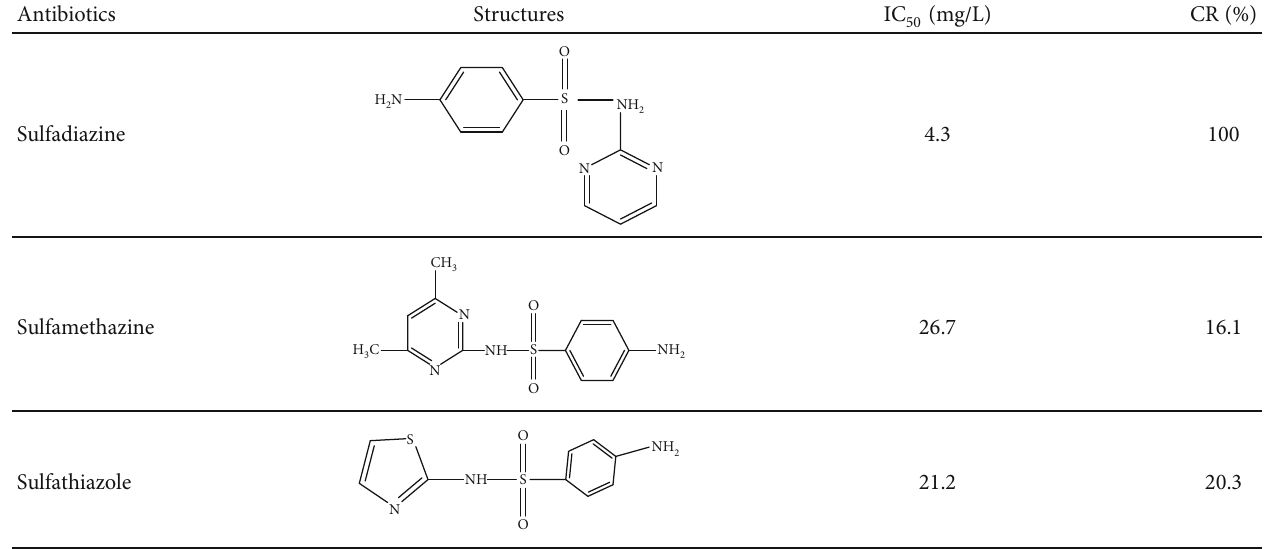
), and cross-reactivity (CR) ratio of three kinds of antibiotic. 50